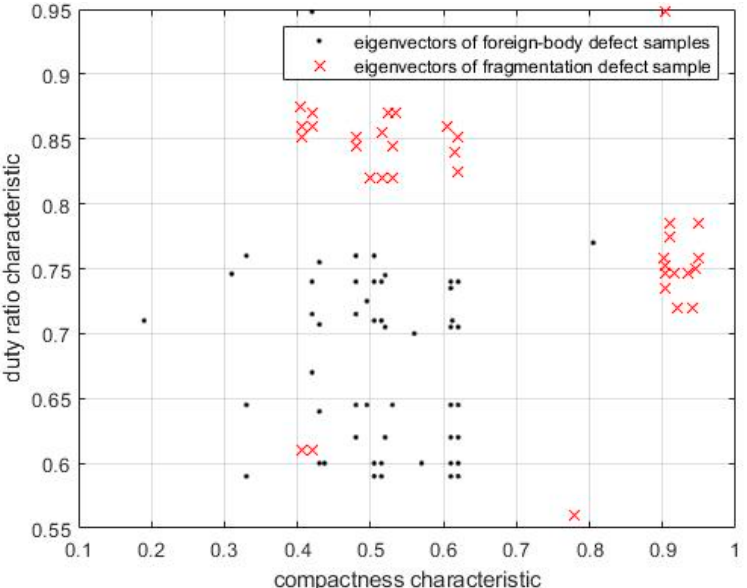
Figure 14. Eigenvector distribution of foreign-body defect and fragmentation-defect